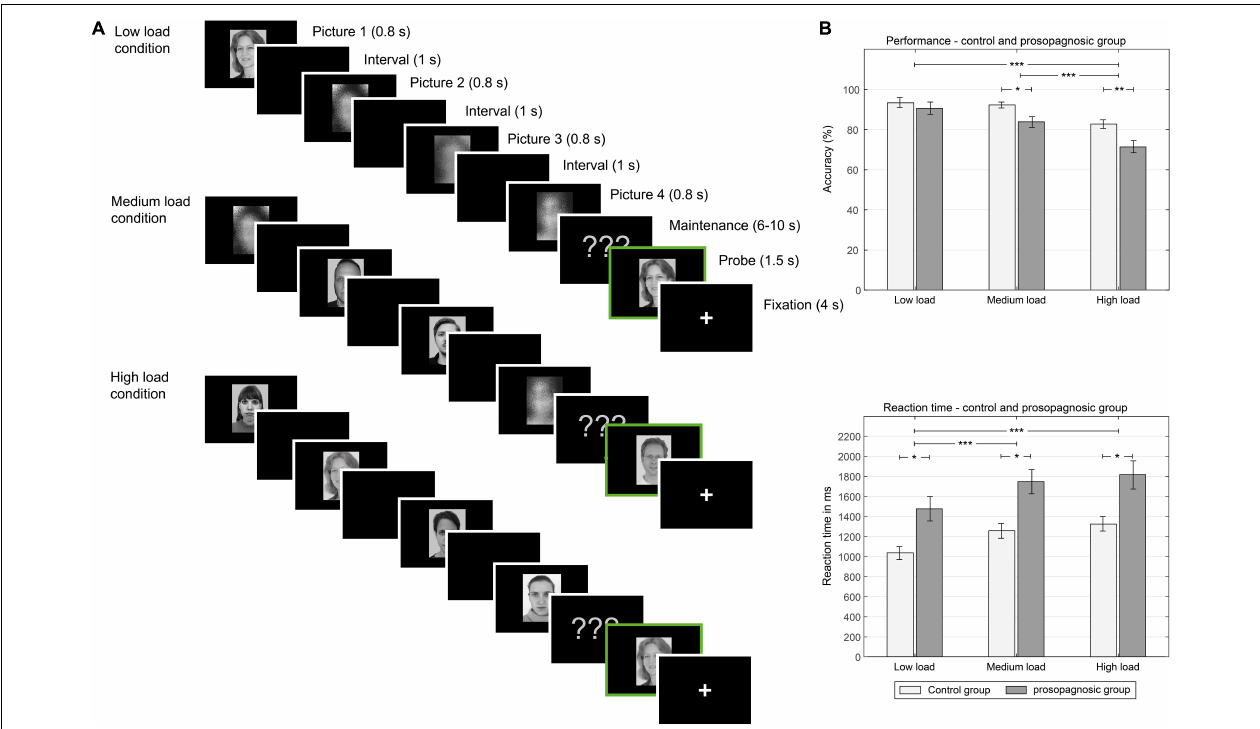
FIGURE 1 | (A) Left: One trial of different experimental conditions (low load, medium load, high load memory condition): In the low load condition, one face, and three scrambled pictures are shown in consequent manner, in the medium condition, two faces and two scrambled pictures are shown. In the high load condition, four faces are shown. Between picture presentation a black screen is shown. Male and female faces are not mixed in one trial. After the encoding phase, a maintenance phase is presented. After the maintenance phase with various time durations, a memory probe is shown (indicated here with a green frame). Subjects decide at this point, if the picture is new or old. (B) Right: behavioral results: Above, performance in the different conditions low, medium and high load for the control and prosopagnosic group; Below, reaction time in ms for the different conditions. *( p < 0.5), **( p < 0.01), ***( p <